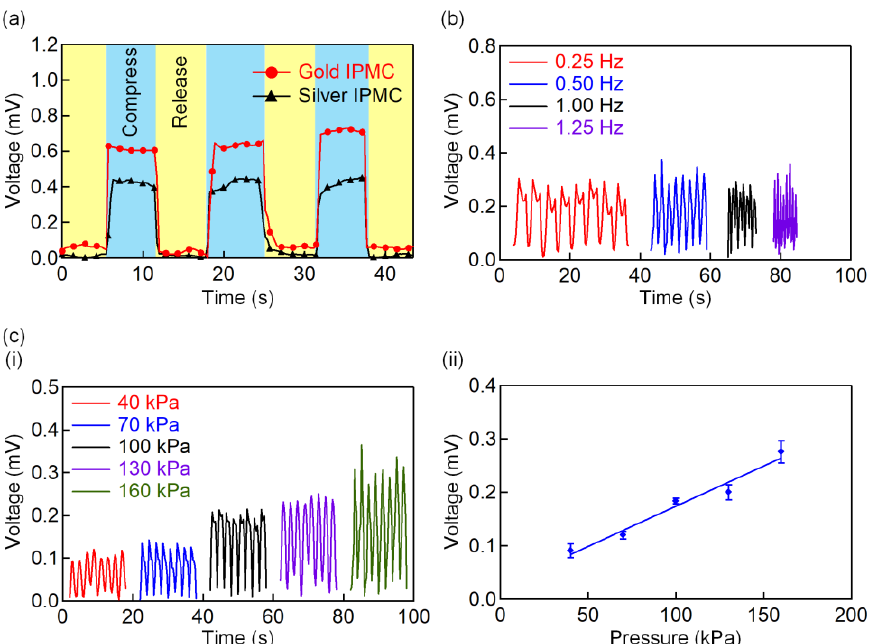
Figure 3. ( a ) Comparison of output voltages between the gold-coated and silver-coated IPMC sensors under three consecutive compress-and-release cycles. ( b ) Temporal response of the gold-coated IPMC sensor with 160 kPa compression pressure under different frequencies. ( c )( i ) Temporal response of the IPMC sensor with increased compression pressure at a constant speed of 0.5 Hz. ( c )( ii ) The output voltage behavior as a function of the applied